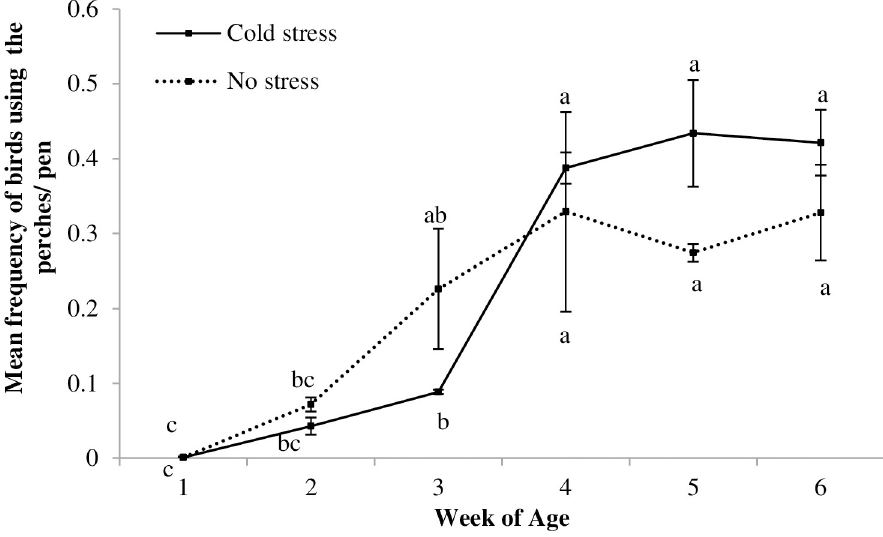
Fig 12. Use of perches by CSTR and NSTR birds. Mean (+ SE) frequency of birds perching for the Cold Stress (CSTR) and No Stress (NSTR) treatments across different weeks; (a-b) letters indicate differences within each treatment across weeks; no differences among treatments were observed in post hoc comparisons regarding each observed